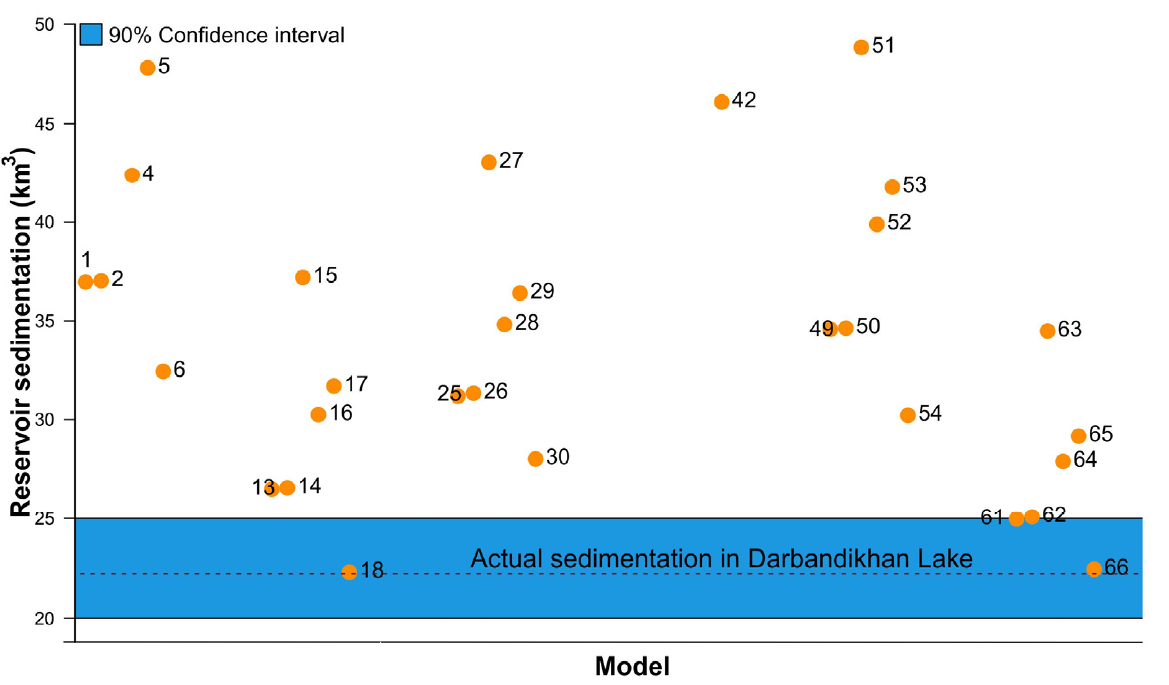
Figure 12. Evaluation of the reservoir sedimentation scenarios tested with the actual sedimentation in the Darbandikhan Lake Basin.